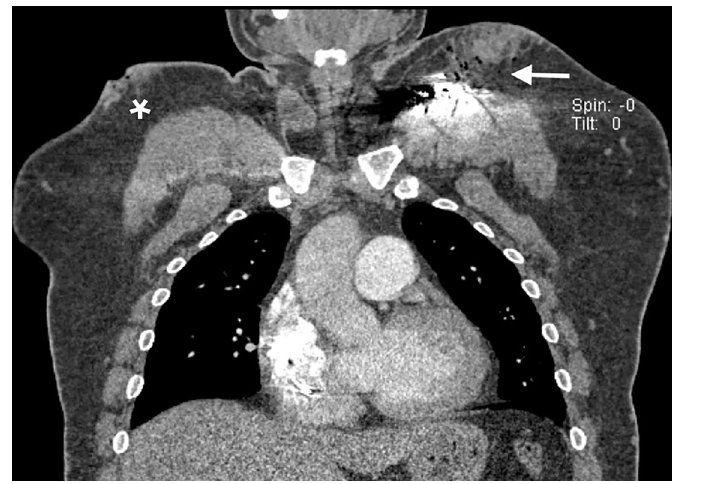
Image 2. Representative computed tomography slice showing damaged automated implantable cardioverter defibrillator with surrounding subcutaneous air (arrow) as well as an additional gunshot wound to the right thorax (star).